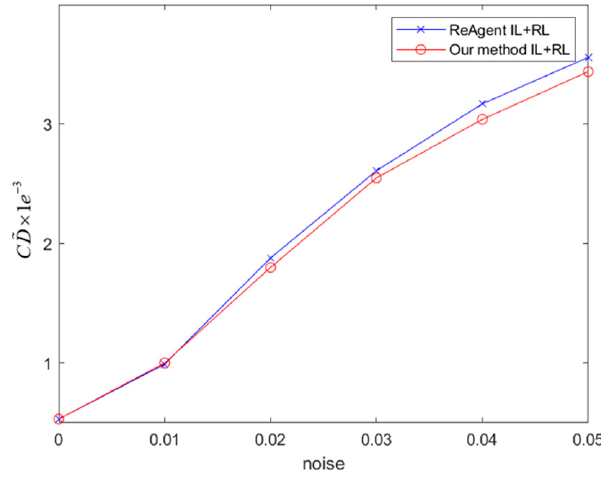
Figure 5. Performance Comparisons under Different Noise Levels.